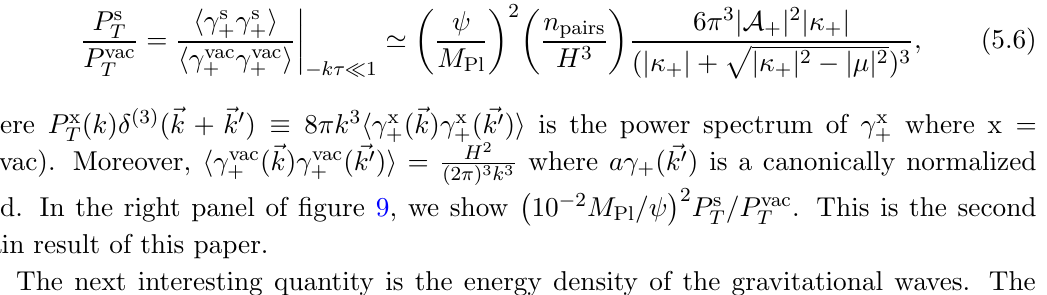
(cid:0) (cid:1) 2 . We show 10 (cid:0) 8 M 2 =H (cid:14)(cid:26) GW = (cid:22) (cid:26) (left) and s Pl 0